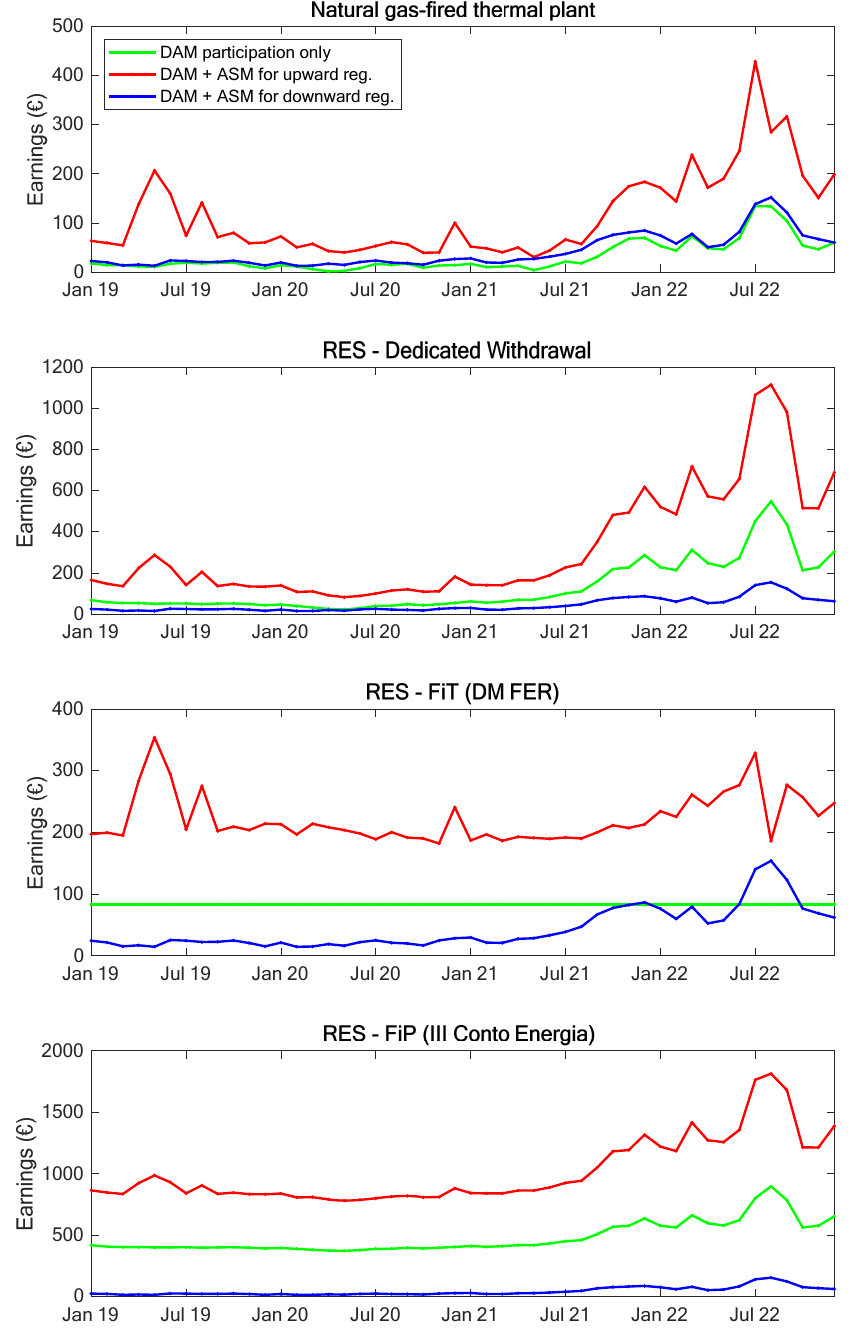
Figure 8. Earnings trend for DER power plants under analysis according to the current regulation. Regarding the provision of downward regulation (represented by the blue curve), one can observe that, according to the average prices registered on the ASM over the period under investigation, the only UP technology taking advantage of the regulation (earnings greater than with the DAM participation only, in green) is the natural gas-fired thermal